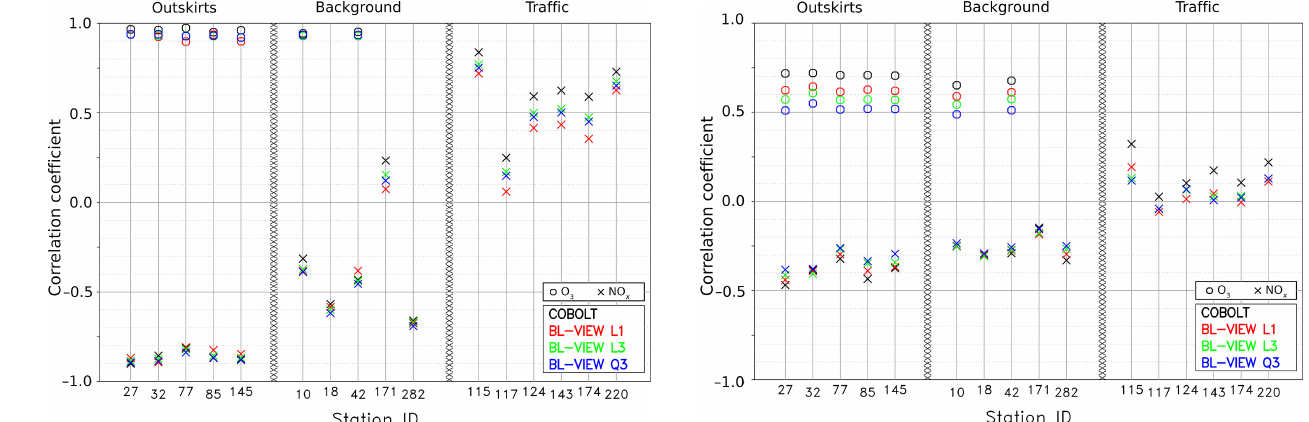
Figure 12. Correlation coefficient R of mean diurnal cycles of MLH and O 3 (circles) and NO x concentrations (crosses), shown for the 16 sites as indicated by the ID number according to Table 1. The four MLH retrievals are color-coded according to the legend. Cor- relations based on MLH averages and O 3 and NO x medians are plotted. Note that at the traffic stations no O 3 -measurements are available.